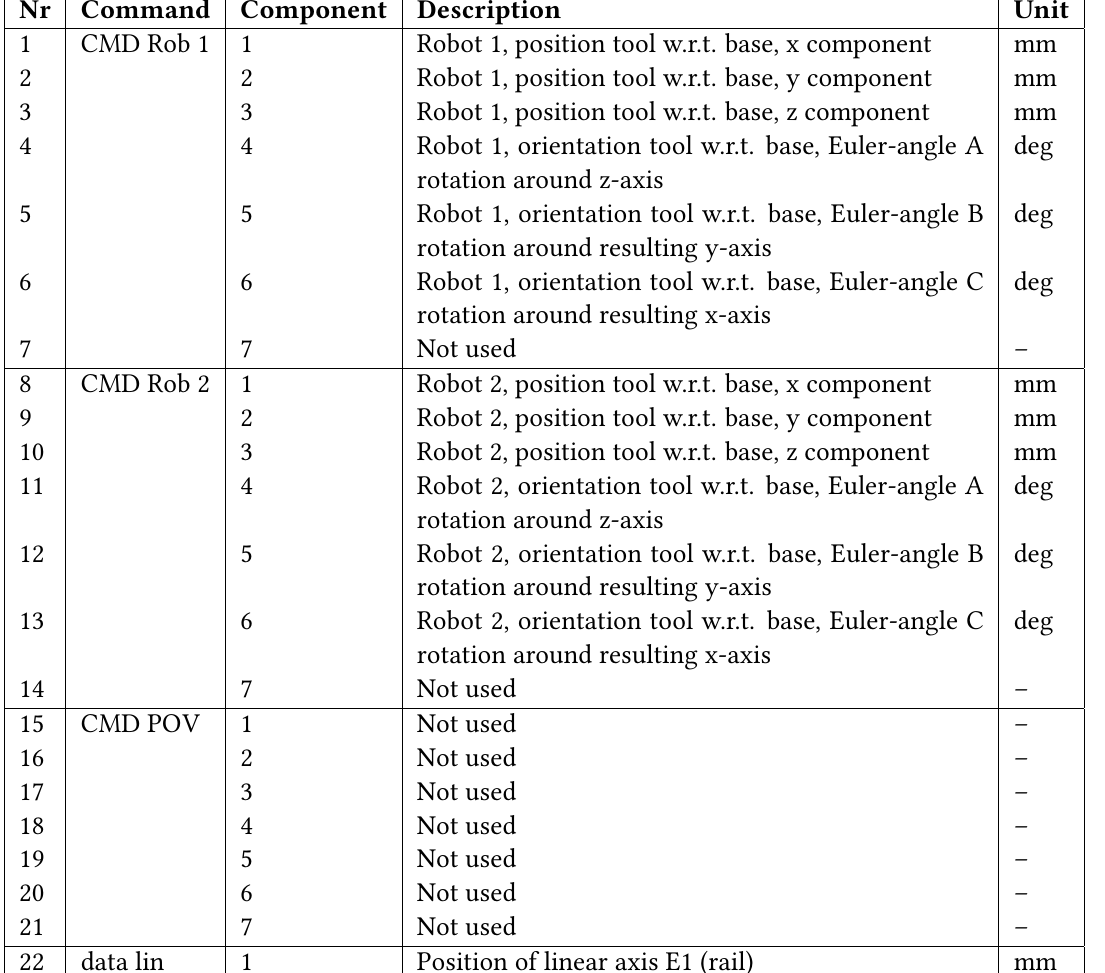
Table 7: Description of the commanding parameters in case of Ideal Device Coordinate system